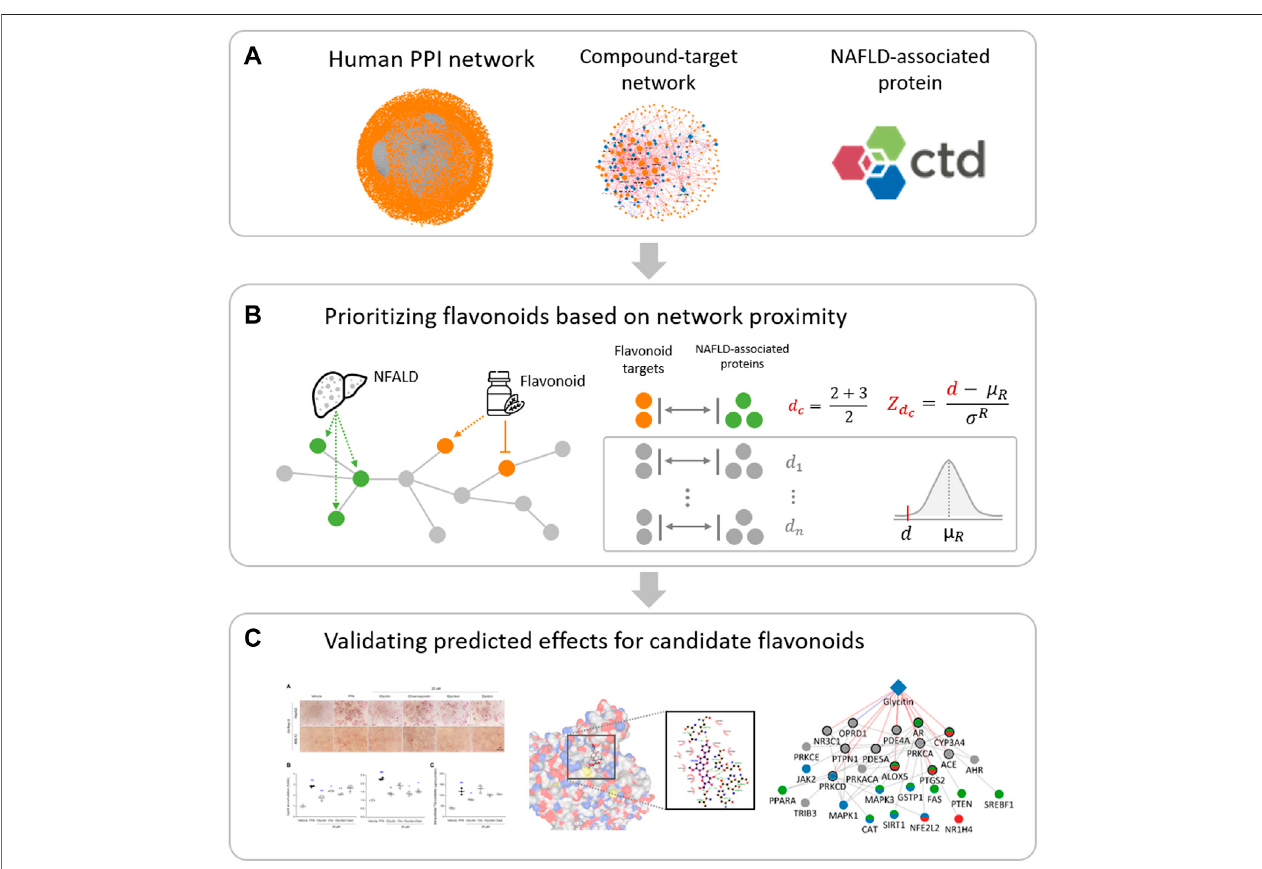
FIGURE 1 | Integrated work fl ow for investigating candidate fl avonoids and their potential mechanisms for NAFLD. (A) Data collection. Human PPI network, compound-target network of fl avonoids, NAFLD-associated proteins were collected from various datasets and databases. (B) Prioritizing fl avonoids based on network proximity.Averageclosestdistance( d c )and itsrelativedistance( Z d c )werecalculatedtoscreenpotential fl avonoidsforNAFLDtreatmentunderthehumanPPInetwork. (C) Experimental validation. The preventive effects of candidate fl avonoids against NAFLD were evaluated using FFA-induced in vitro model, molecular docking, and network